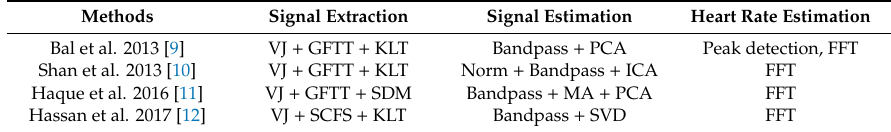
Table 1. Summary of published remote ballistocardiography (BCG)